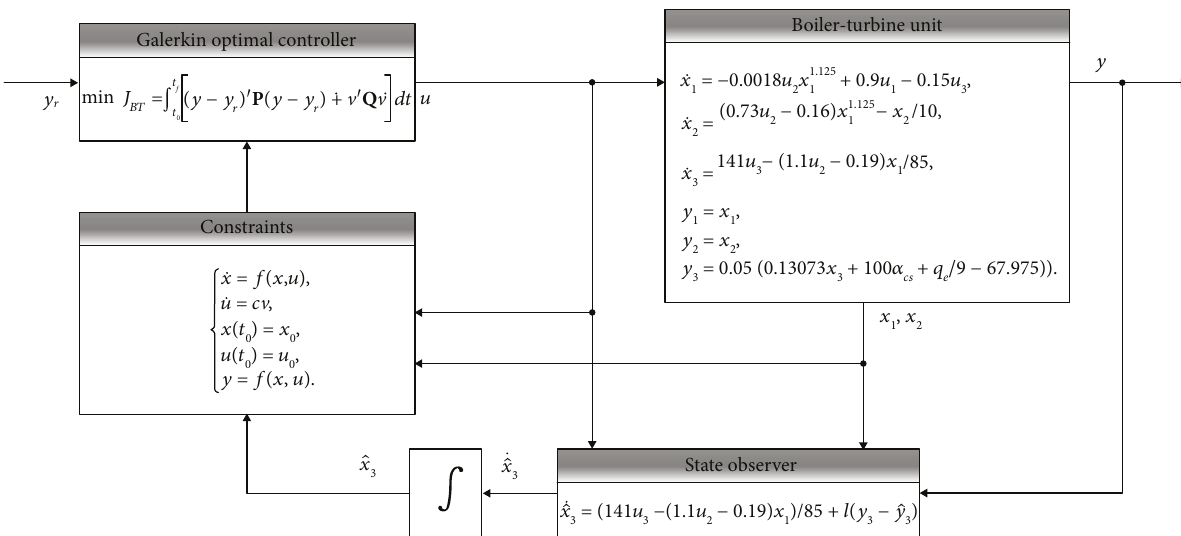
3 Boiler-turbine unit